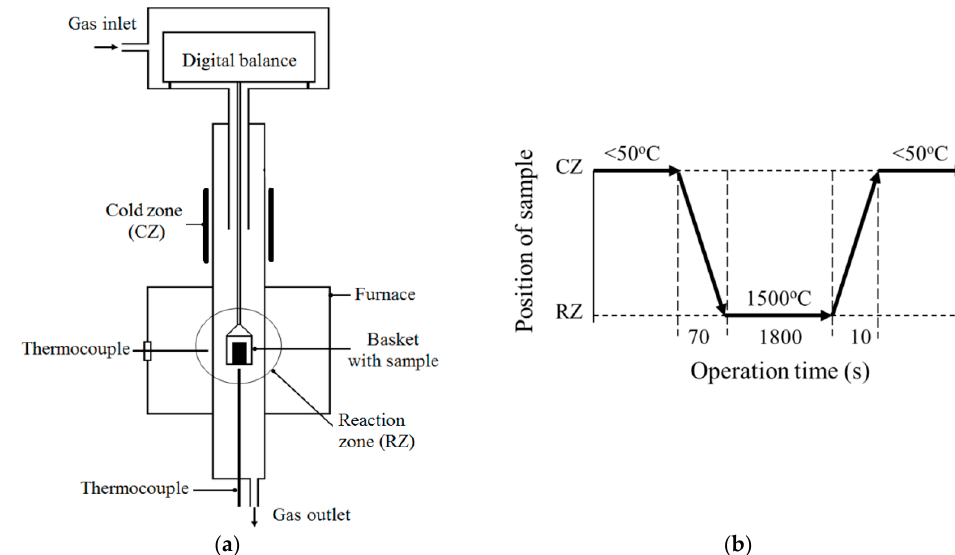
Figure 2. Schematic illustrations of the equipment setup ( a ) and the main operational description of the TGR experiment ( b ).